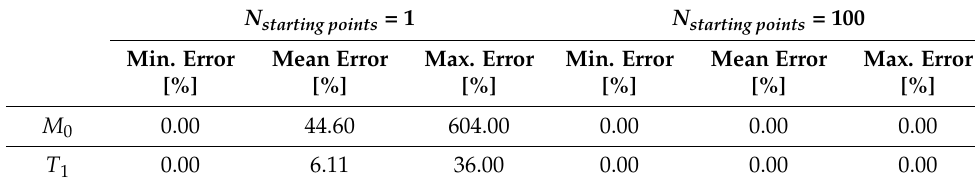
Table 1. Relative error of estimated coefficients—comparison of multiple starting points. N starting points = 1 N starting points = 100 Min. Error Mean Error Max. Error Min. Error Mean Error Max. Error [%] [%] [%] [%] [%] [%] M 0 0.00 44.60 604.00 0.00 0.00 0.00 T 1 0.00 6.11 36.00 0.00 0.00